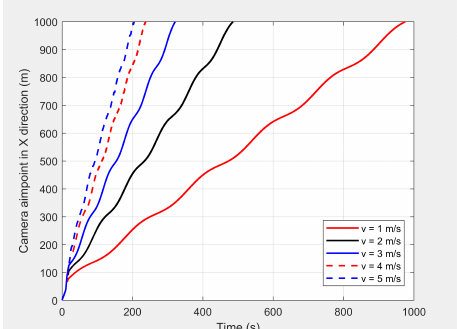
Figure 12. The camera’s aim point for the UAV’s planned path when following the MGV while moving at different constant